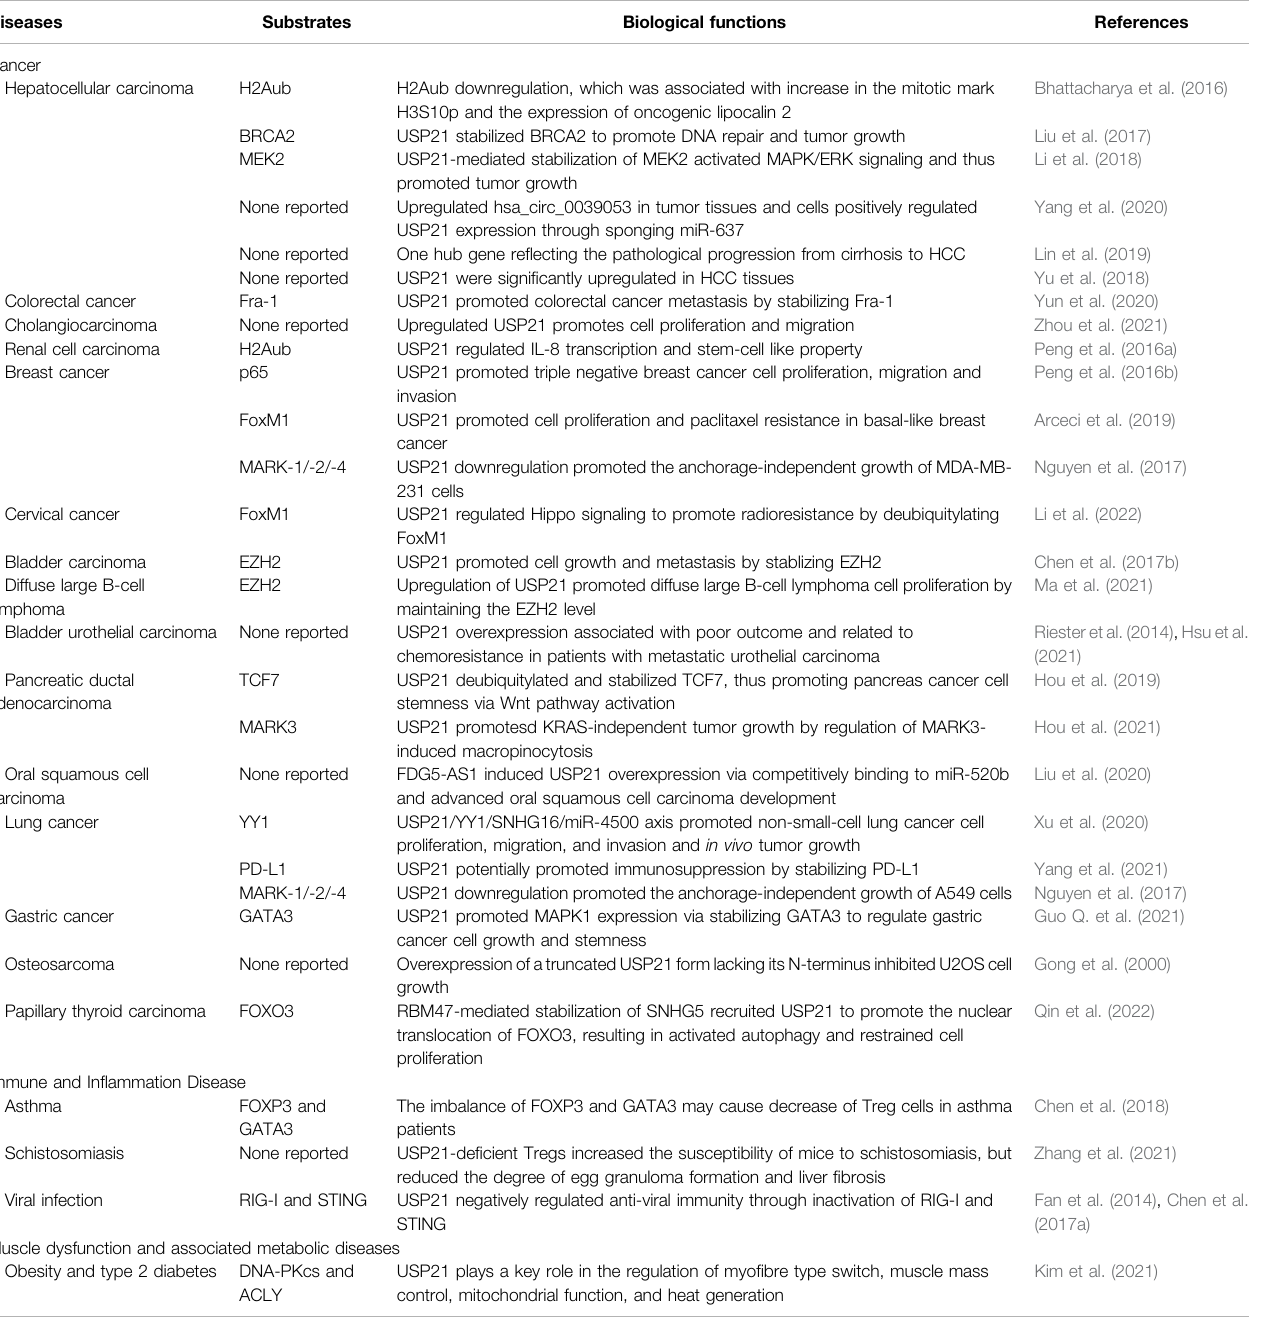
TABLE 3 | Multifaceted role of USP21 in